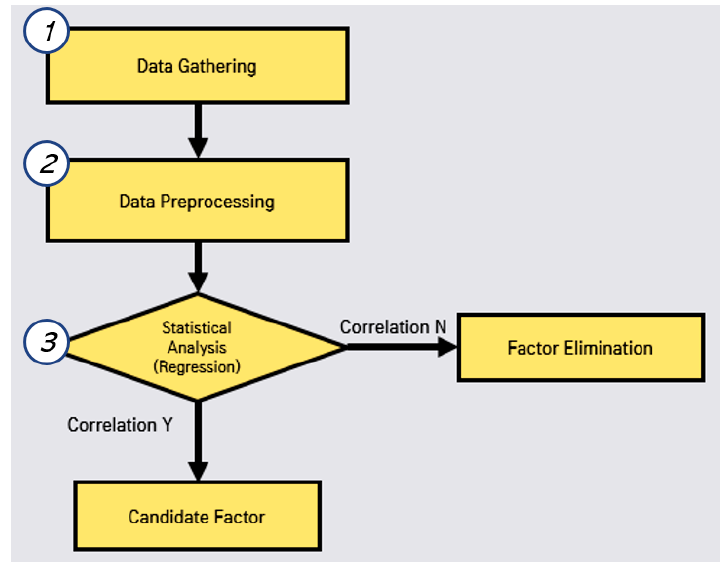
Figure 2. Process of correlated factor selection.